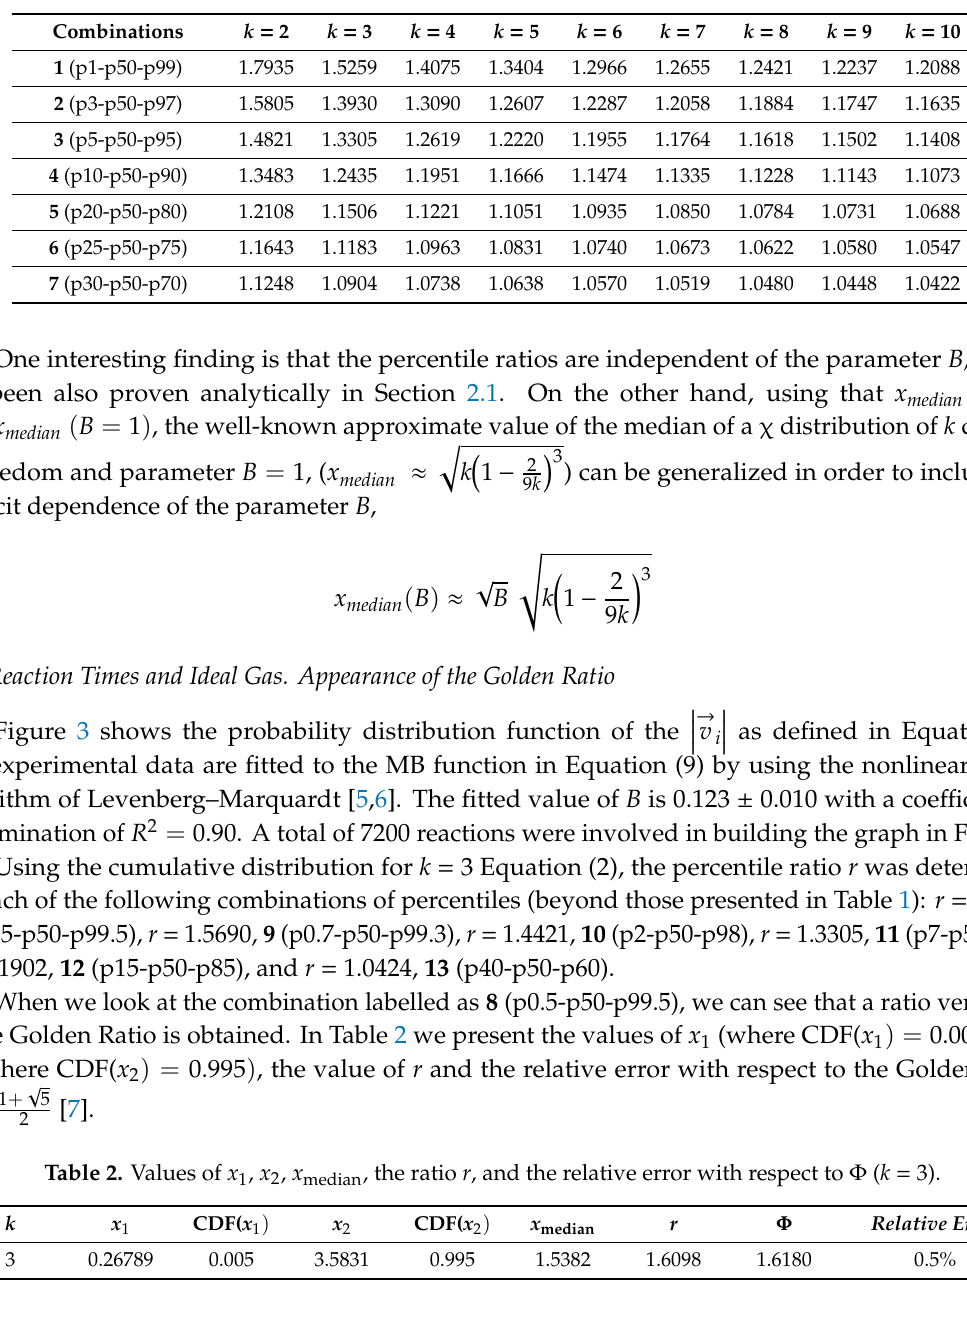
Table 1. Ratios (r) for di ff erent combinations of percentile. As demonstrated above, these ratios are independent of the values of B chosen in Equations (1) and (2).